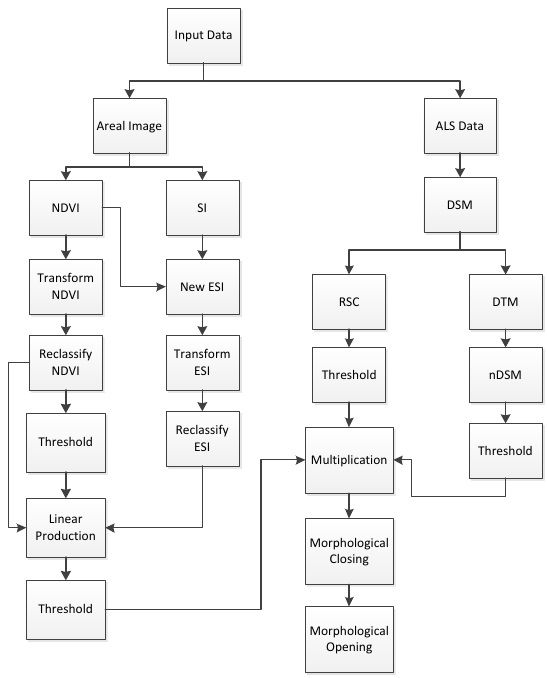
Figure . Representation of methodological workflow in